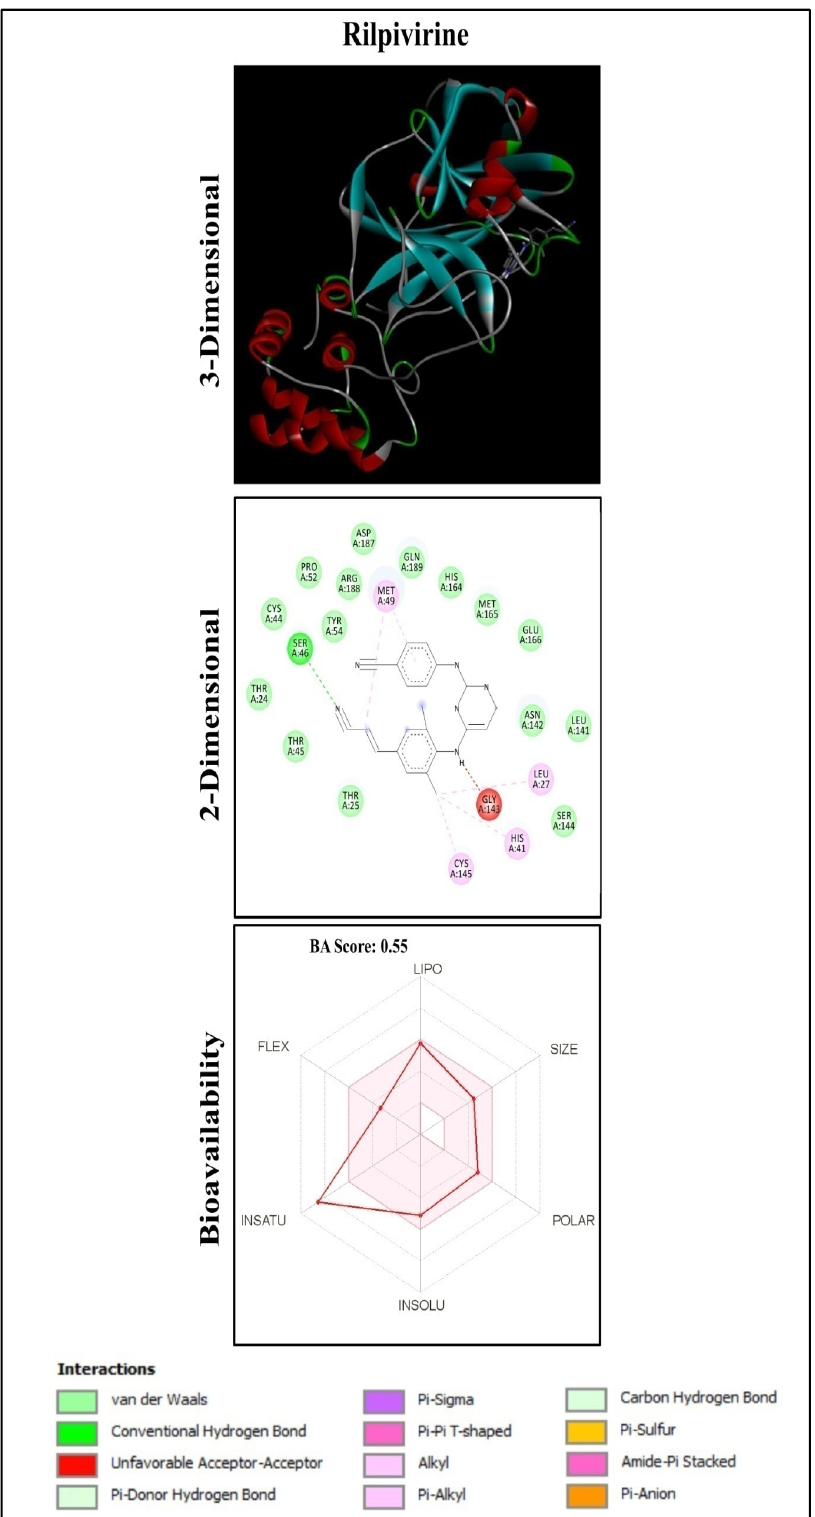
Figure 1. Anti-HIV compounds Pseudohypericin and Hypericin docked with M pro of SARS-CoV-2.